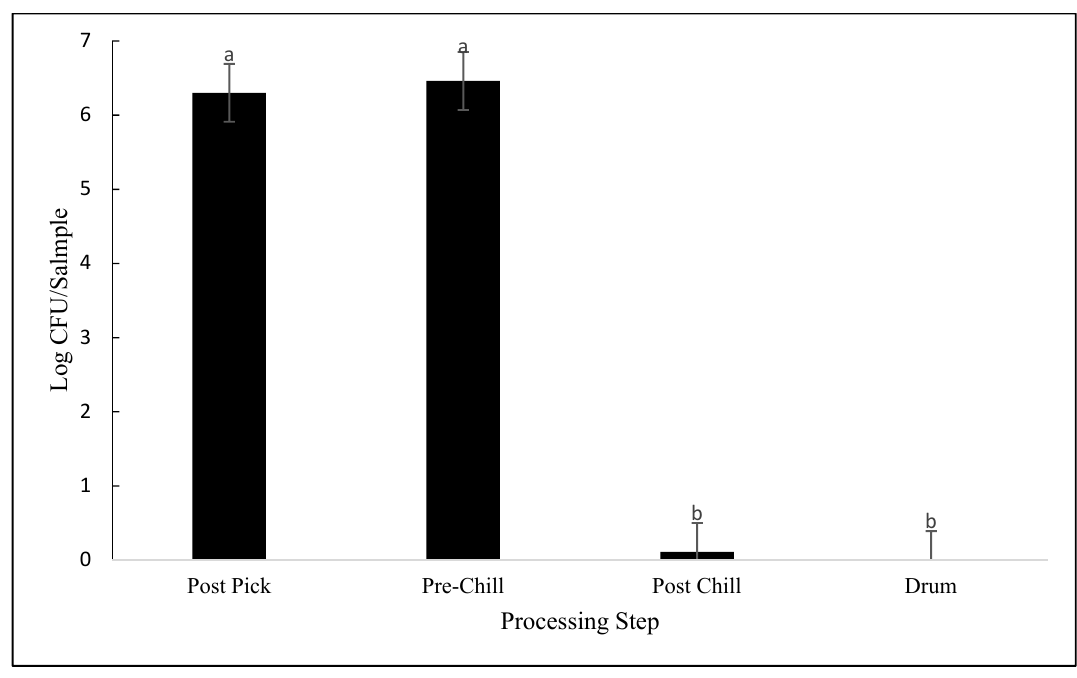
Figure 4. Lactic acid bacteria contamination expressed as log CFU/sample, detected from samples collected at post ‐ pick, pre ‐ chill, post ‐ chill, and drumsticks ( p < 0.001). Means with different letters differ statistically.